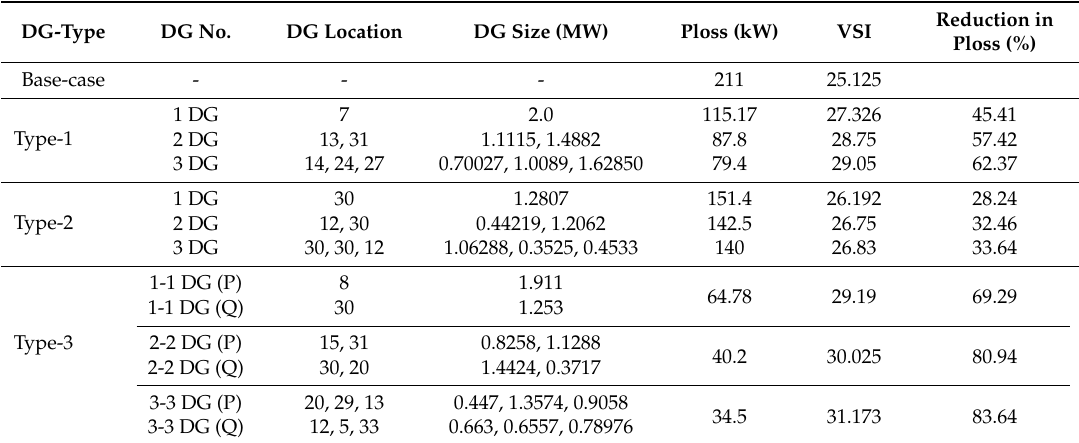
Table 1. Optimal placement and sizing of DG for case study-I as single-objective function with priority to 1st objective